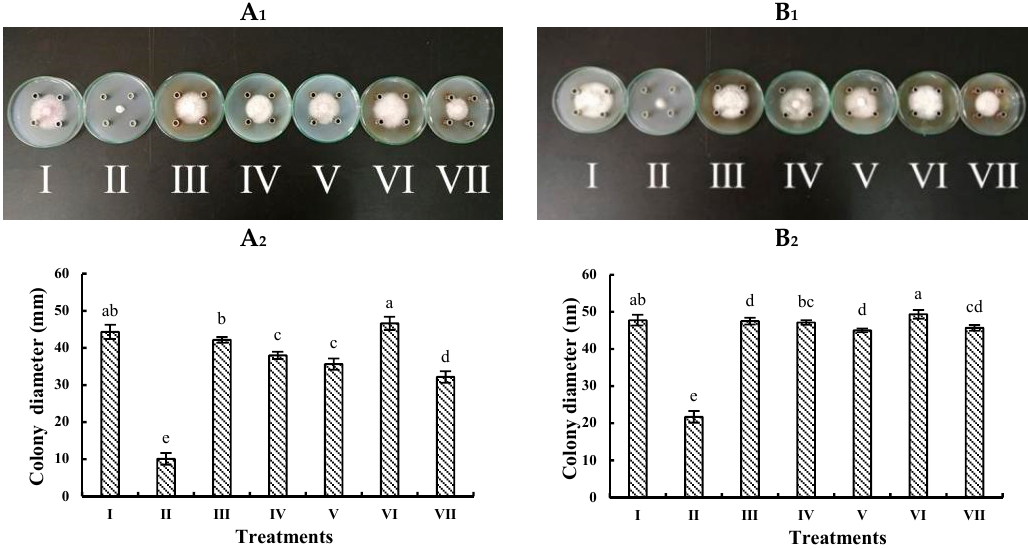
Figure 3. Inhibitory effect of fractions II − VII from A . annua on F . oxysporum and F . solani . A 1 : The mycelium growth of F . oxysporum for 5 days. B 1 : The mycelium growth of F . solani for five days. A 2 : The colony diameter (mm) of F . oxysporum under different components. B 2 : The colony diameter (mm) of F. solani under different components. I: Negative control; II: EO; III: Water soluble extract; IV: Methanol soluble extract; V: Chloroform soluble extract; VI: Water soluble extract; VII: Methanol soluble extract directly extracted by ultrosonic method. Note: In the same figure, different letters represent significant differences ( p < 0.05) among different treatments, while with the same letters mean no significant difference ( p > 0.05).